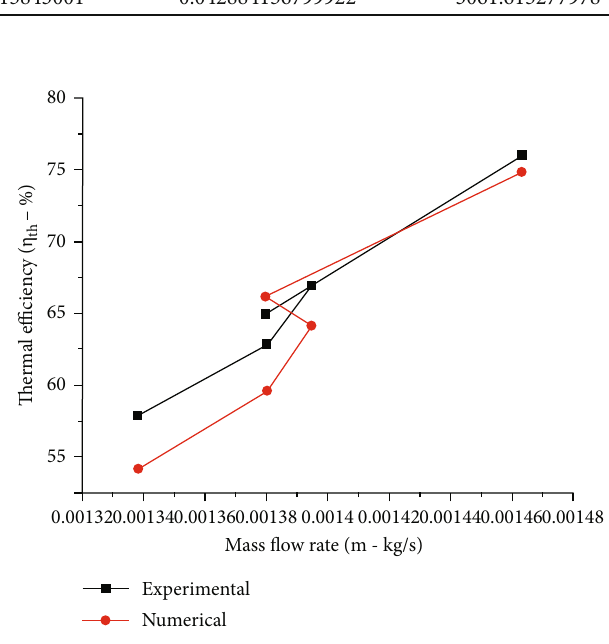
Figure 18: Comparative behavior of experimental and numerical thermal e ffi ciency of the system with mass fl ow rate.